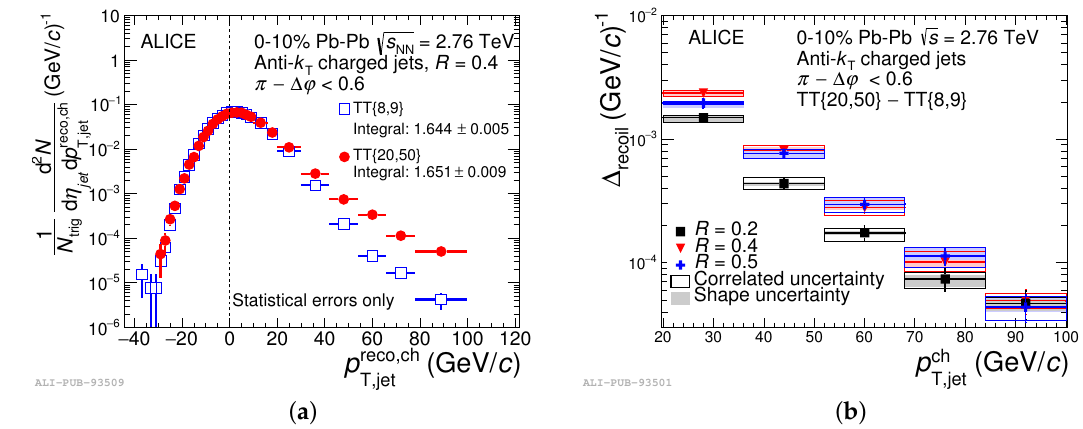
Figure 1. ( a ) Per trigger normalized transverse momentum spectra of recoil jets associated with trigger track p T bins TT{8,9} and TT{20,50} measured in the 0–10% centrality bin of Pb–Pb collisions at √ s NN = 2.76TeV. ( b ) Fully corrected ∆ recoil distributions for track-based anti- k T jets with R = 0.2, 0.4, and 0.5. Systematic uncertainties in the data are shown by boxes. Taken from [14].